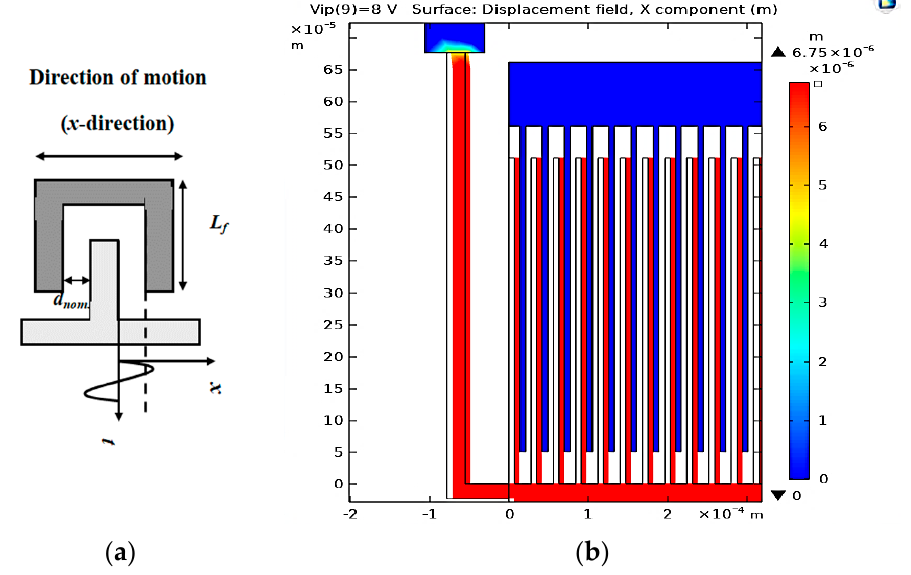
Figure 5. ( a ) The two finger representation of the converter and ( b ) the converter’s maximum Figure 5. ( a )Thetwofingerrepresentationoftheconverterand( b )theconverter’smaximum displacement.